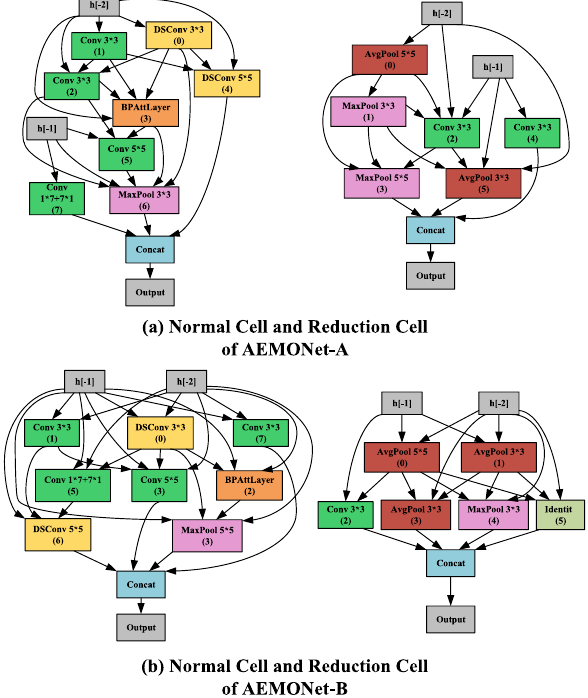
Fig.8 DetailsofnormalcellandreductioncelloftheAEMONet-Aand